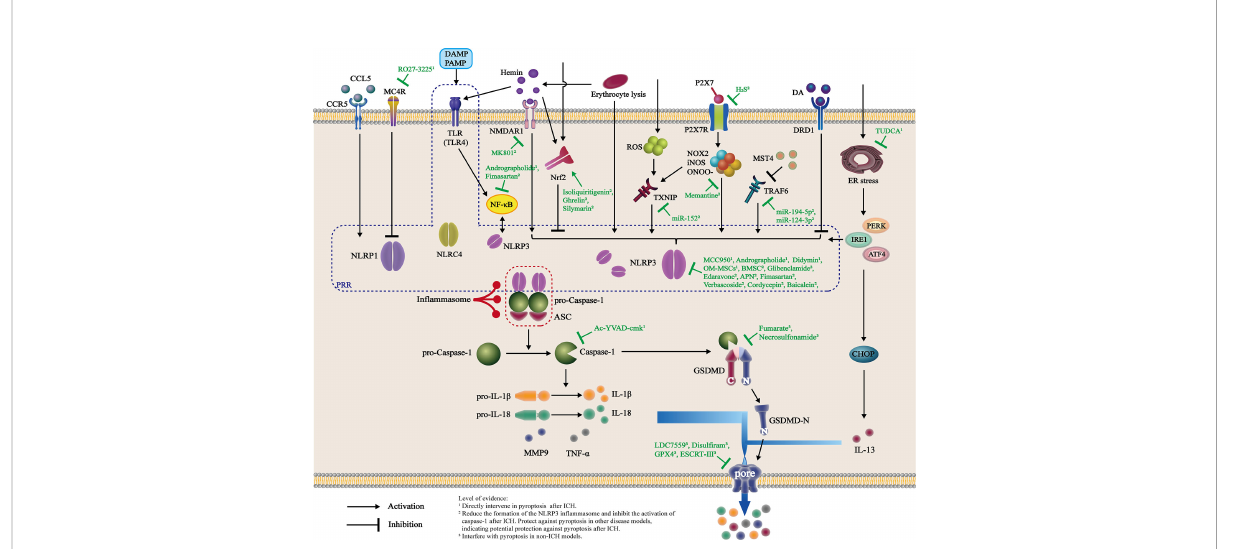
FIGURE 2 Activation and intervention of the pyroptosis pathway after ICH. Changes in the internal environment of the brain after ICH directly or indirectly activate PRR, as represented by NLRP3, through multiple pathways. These molecules recruit ASC and pro-caspase-1 and interact to form in fl ammasomes, which cleave pro-caspase-1 into active caspase-1. Caspase-1 cleaves both pro-IL-1 b and pro-IL-18 into mature IL-1 b and IL- 18, respectively, and GSDMD to form GSDMD-N fragments. GSDMD-N binds to the plasma membrane and forms pores in the membrane, inducing the release of mature in fl ammatory factors such as IL-1 b , IL-18, and TNF- a and subsequently recruiting more extracellular in fl ammatory cytokines and causing in fl ammation. Currently, animal- and cell-based experiments have shown that various drugs intervene in the formation of in fl ammasomes after ICH through different targets. Additionally, some candidate drugs are believed to directly interfere with pyroptosis after ICH, reducing the release of in fl ammatory factors and inhibiting neuroin fl